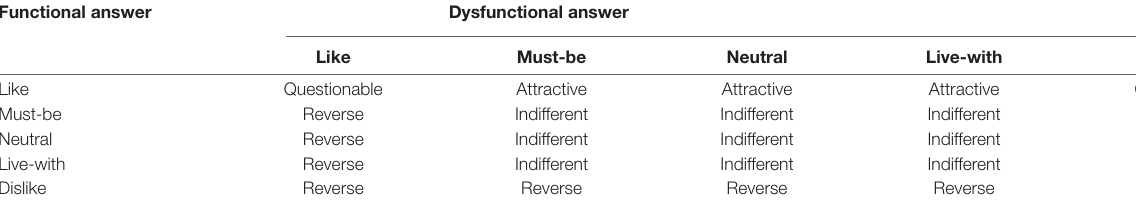
TABLE 3 | Spiritual human factors classification for an individual.